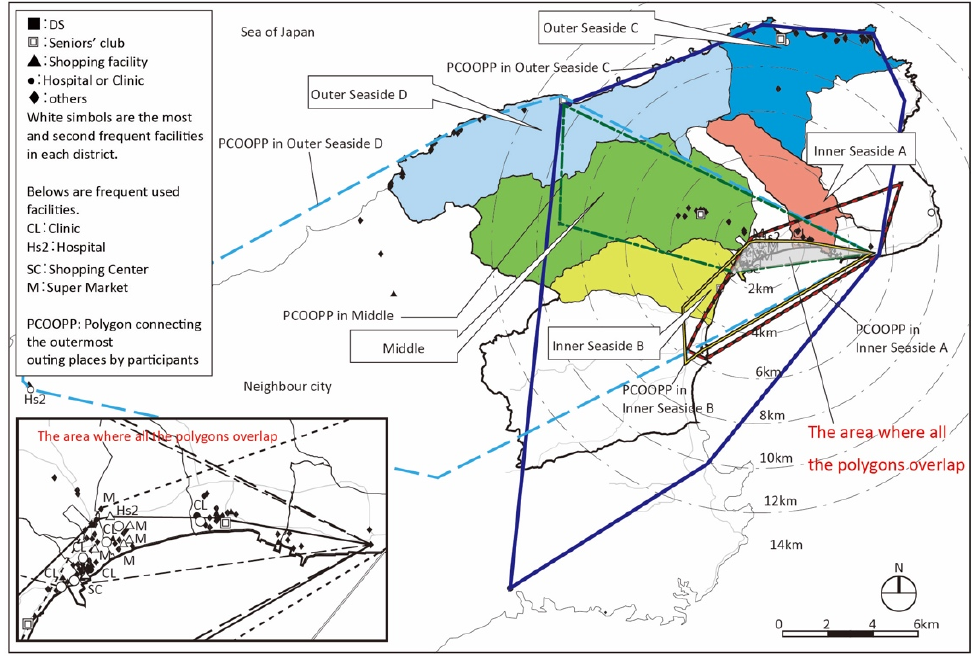
Figure 11. Polygons connecting outermost places visited by participants in each district in Suzu.